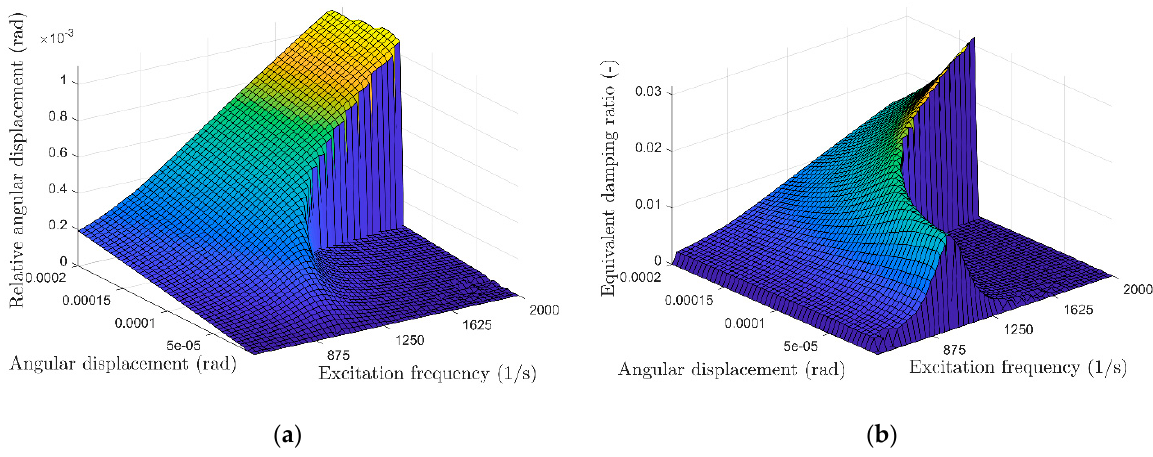
,(cid:2033) (cid:2868) = 1000 (cid:2869) , Ω = 1250 (cid:2869) , (cid:1836) = 0.2 (cid:1863)(cid:1859)(cid:1865) (cid:2870) ). ( a ) , ω 0 = 1000 1 , Ω = 1250 1 , J = 0.2 kgm 2 ). s s s (cid:3046) (cid:3046) (cid:3046)